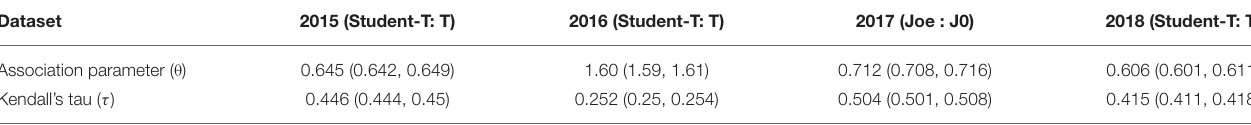
TABLE 4 | Association parameters as confirmation of the presence of significant dependence.